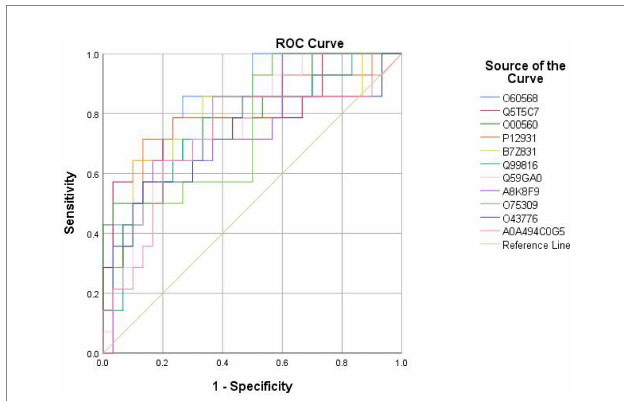
FIGURE 7 ROC curves obtained of the top 11 differential expressed proteins identified by proteomics analysis, including O60568 (PLOD3), Q5T5C7 (not named), O00560 (SDCBP), P12931 (SRC), B7Z831 (GPRC5B), Q99816 (TSG101, STP22, VPS23), Q59GA0 (THY1, CD90), A8K8F9 (PLCD), O75309 (CDH16), O43776 (NARS, asnS), A0A494C0G5